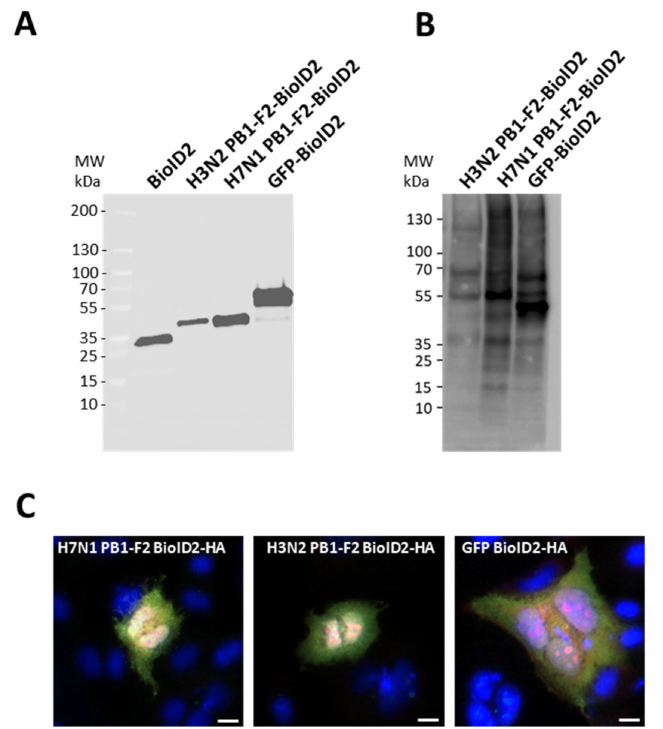
Figure 2. ( A ) Expression of BioID2-HA-tagged constructs were confirmed in A549 cells by SDS- PAGE 24 h post-transfection and analyzed by Western blot using an anti-HA antibody. ( B ) Proteins biotinylated by BioID2 constructs were detected with HRP-conjugated streptavidin. ( C ) A549 cells expressing BioID2-fusion proteins were assessed for localization (green) and proximity biotinylation (red) following the addition of exogenous biotin. Scale bars, 10 µ